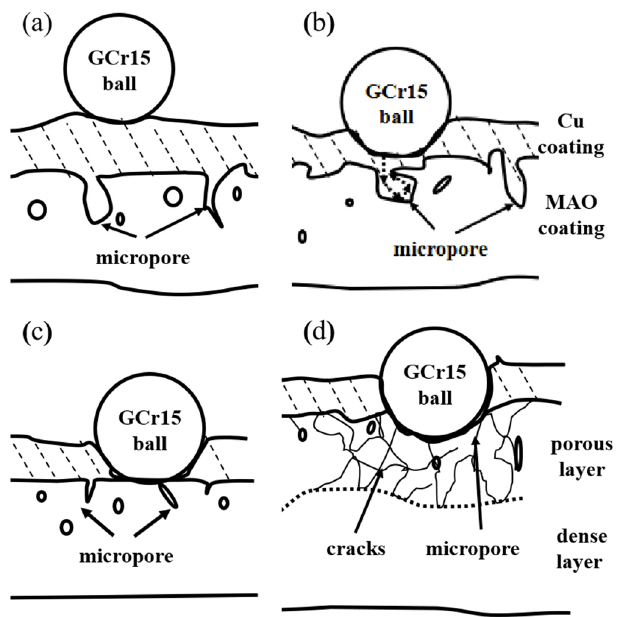
Figure 6. Schematic diagram of friction test of MAO + Cu composite coatings: ( a ) before; ( b ) first stage; ( c ) second stage; ( d ) third stage.